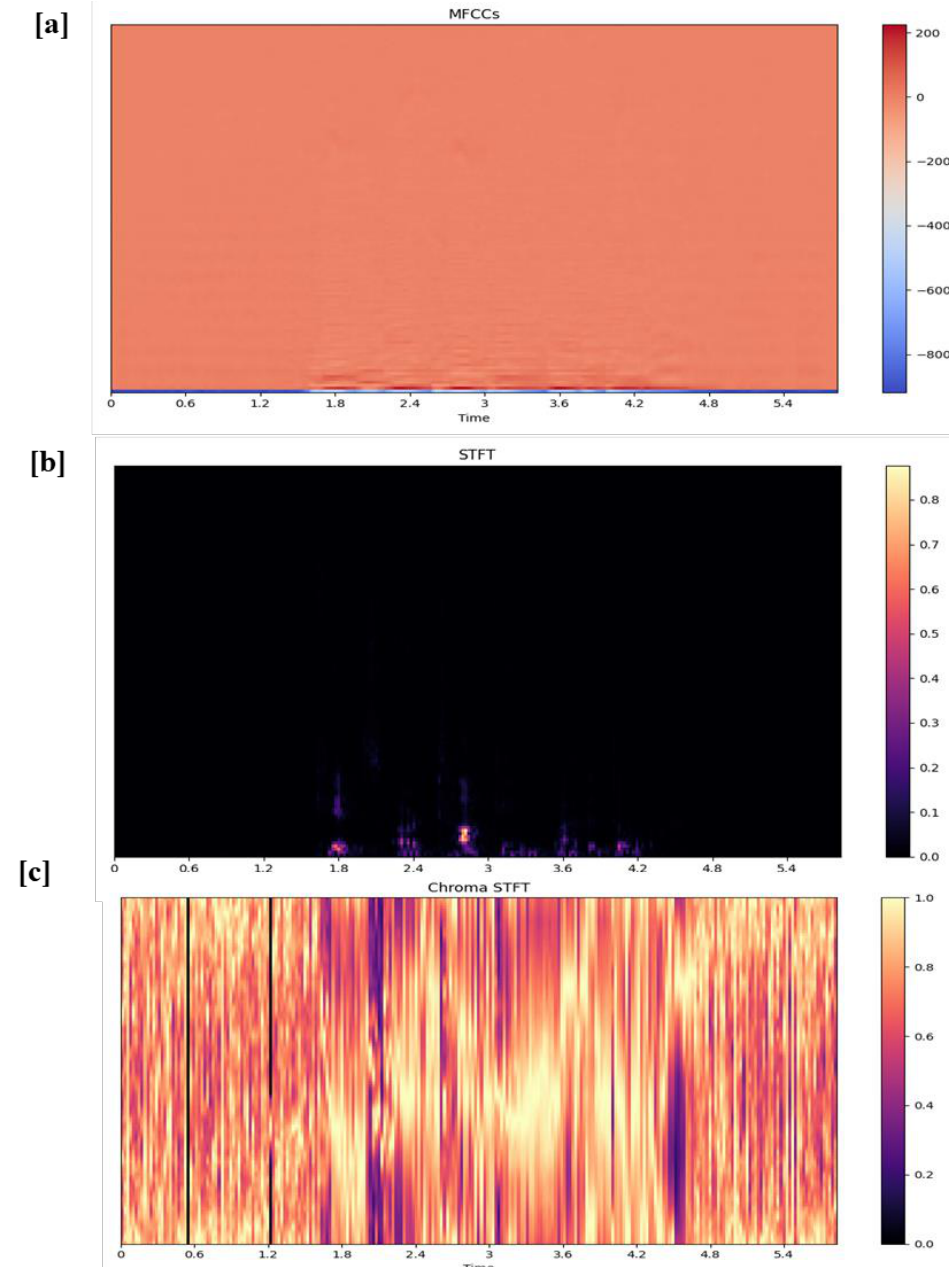
Figure 6. Sample transformed feature of ( a ) MFCC (128 × 512), ( b ) STFT (128 × 512), and ( c ) Chroma STFT (128 ×